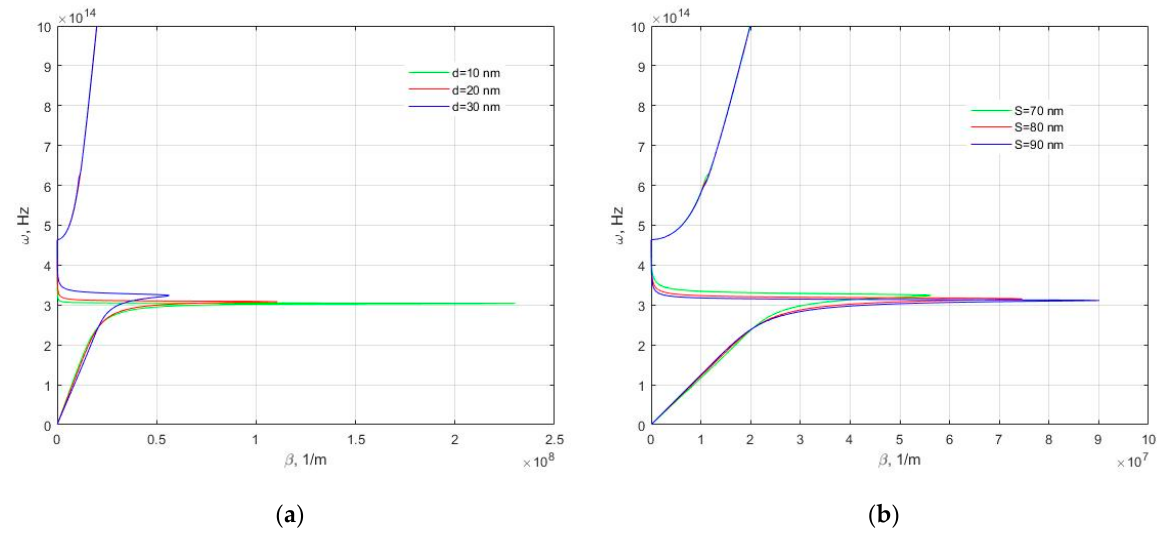
Figure 5. Dispersion relations of SPPs for changeable nanowire metamaterial geometry: ( a ) S = 70 nm, ( b ) d = 30 nm.